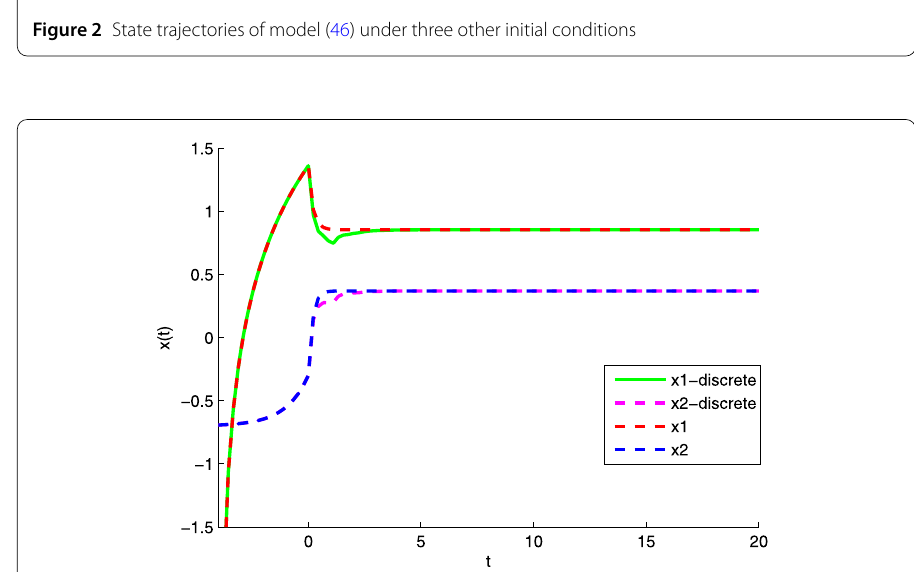
Figure 3 State trajectories of model (46) without distributed delay, or without